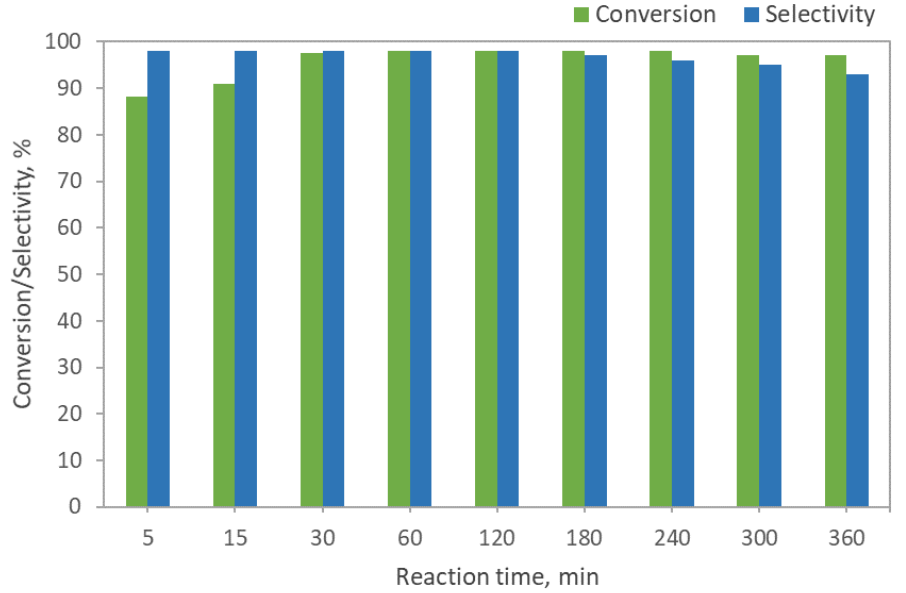
Figure 4. Hydroxypivaldehyde synthesis in a flow reactor. Reaction conditions: 40 wt.% K 2 CO 3 ; PEG 600-PS, 0.5 mol%; 40 °C; 600 rpm; 2 h. Reaction time was the sampling time after exceeding the residence time. Flow rate of pump A: 0.01 mL/min; flow rate of pump B: 0.02 mL/min; total flow rate: 0.03 mL/min. Residence time: 50